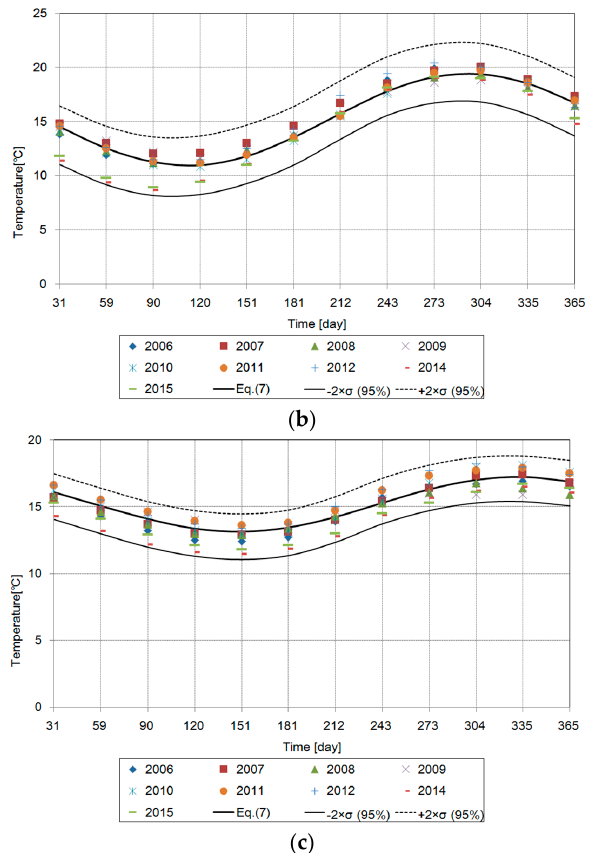
Figure 6 . Comparison of experimental and predicted ground temperature distributions in Incheon, Korea: ( a ) depth of 1 m; ( b ) depth of 3 m; ( c ) depth of 5 m.